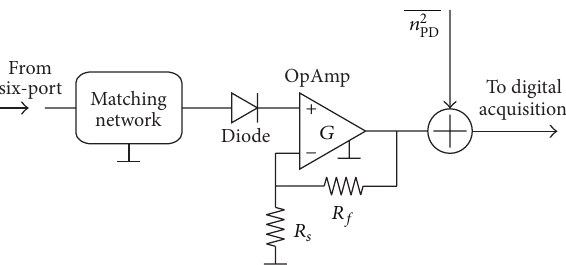
Figure 7: Power detection and baseband circuitry schematic.